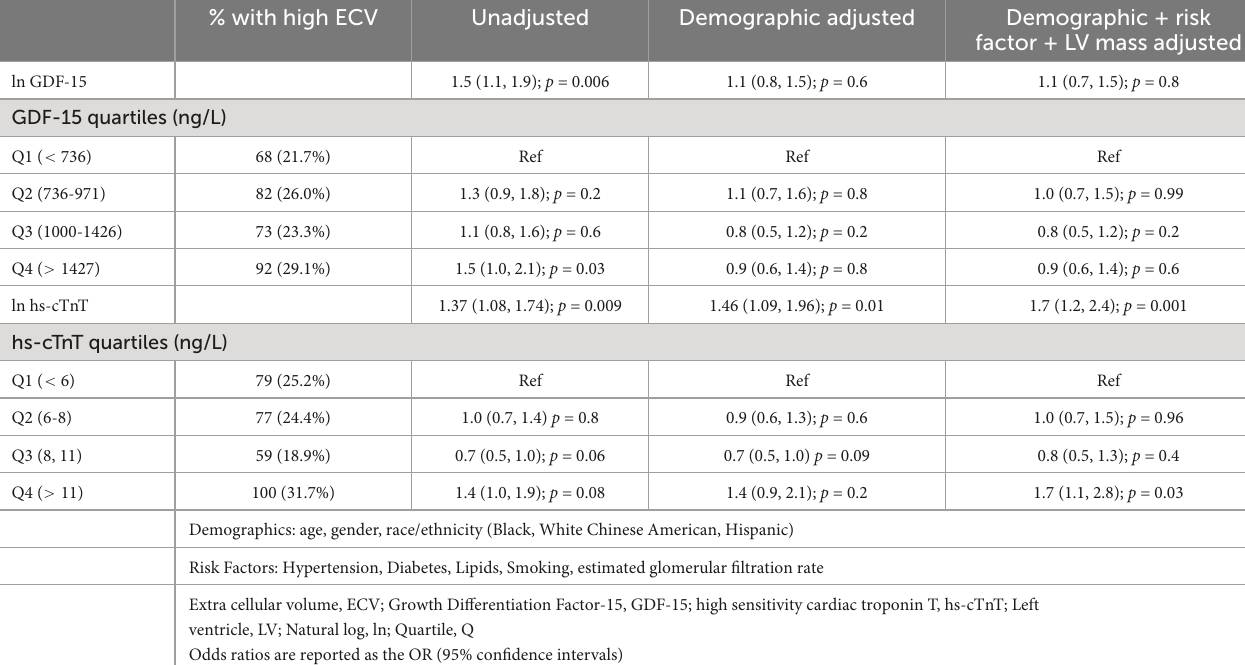
factor + LV mass adjusted